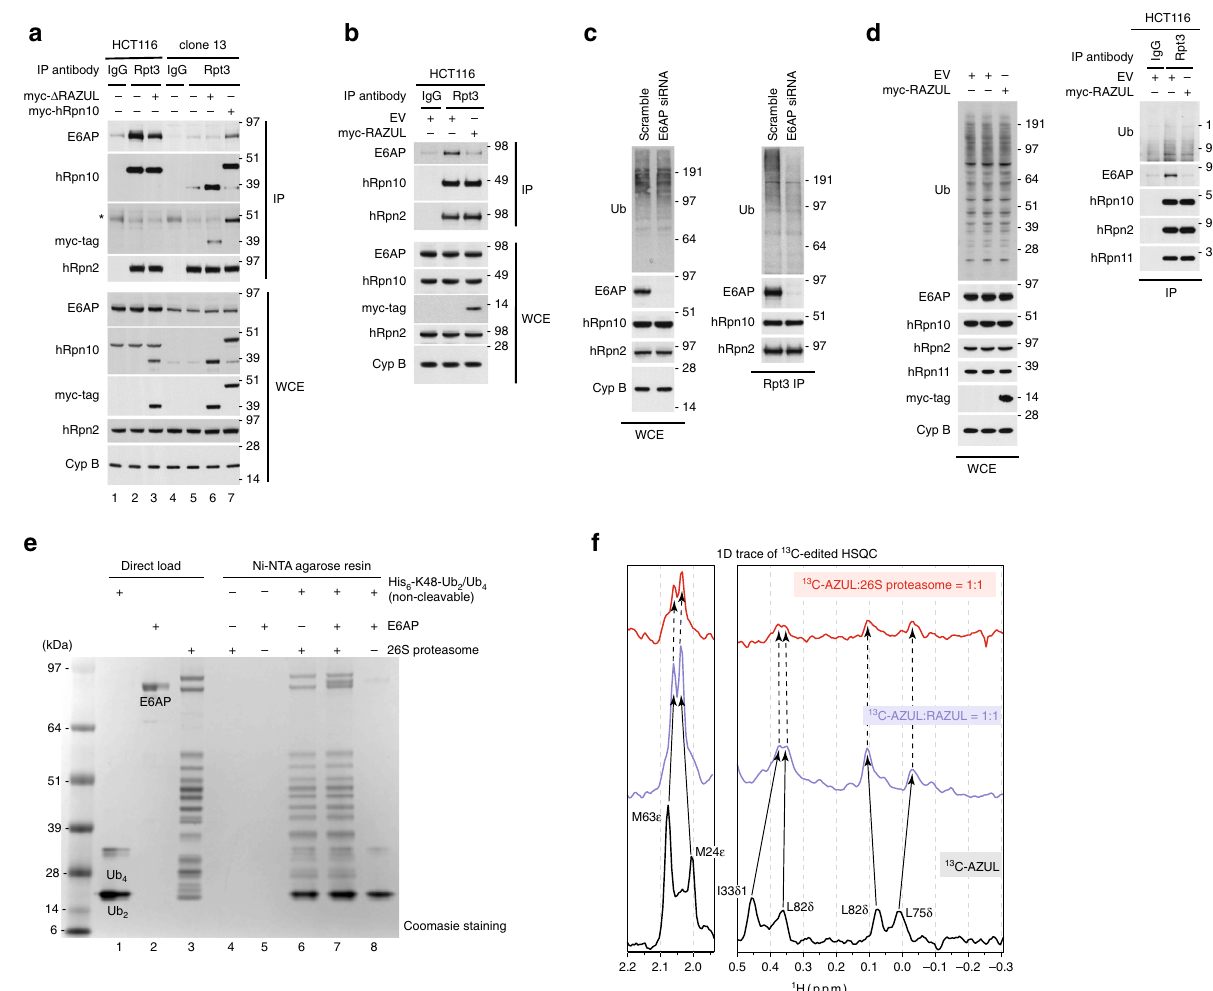
Fig. 4 hRpn10 RAZUL contributes E6AP to the proteasome. a Immunoblots of Rpt3 immunoprecipitates or WCE from HCT116 or clone 13 lysates expressing myc-hRpn10 constructs. An asterisk “ * ” indicates heavy chain antibody. Cyclophilin B (Cyp B) is used as a loading control for WCE samples in a – c and hRpn2 as a positive control for the immunoprecipitation. IgG controls are included. b , d Immunoblots of Rpt3 or IgG (control) immunoprecipitates or WCE of lysates from HCT116 cells transfected with empty vector (as a control) or myc-hRpn10 RAZUL. c Immunoblots of Rpt3 immunoprecipitates or WCE from lysates of HCT116 cells transfected with a scrambled control or siRNA against E6AP. a – d Antibodies used for immunoprobing are indicated to the left of each panel. e Pull-down assay for a commercially available mixture of His 6 -tagged, non-cleavable K48-linked Ub 2 /Ub 4 with incubation of human 26S proteasome (lane 6), 26S proteasome with equimolar E6AP (lane 7), or just E6AP (lane 8). E6AP or 26S proteasome was added to Ni-NTA agarose resin as negative controls (lanes 4 and 5). K48-linked Ub 2 /Ub 4 , E6AP, and 26S proteasome were loaded directly in lanes 1 – 3, as indicated. f Selected regions from 1D 13 C-edited, 1 H NMR experiments acquired at 850 MHz and 25 °C for free 13 C-AZUL (black) or mixtures with equimolar unlabeled RAZUL (blue) or 26S proteasome (red). The concentration of each sample was 0.3 μ M and 200,000 scans were recorded for each experiment. Source data are provided as a Source Data fi